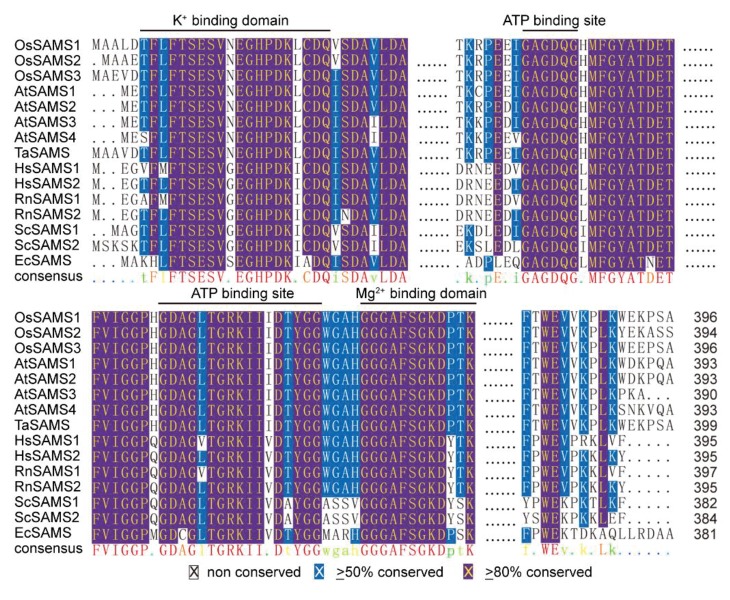
Multiple alignments of SAM synthetase proteins. The amino acid secquence of OsSASM1 synthetase protein (Q0DKY4.1) were aligned with Oryza sativa SAM synthetase 2 (OsSAMS2, P93438.1), O. sativa SAM synthetase 3 (OsSAMS3, Q9LGU6.1), Arabidopsis thaliana SAM synthetase 1 (AtSAMS1, P23686.2), A. thaliana SAM synthetase 2 (AtSAMS2, P17562.1), A. thaliana SAM synthetase 3 (AtSAMS3, Q9SJL8.1), A. thaliana SAM synthetase 4 (AtSAMS4, Q9LUT2.1), Triticum aestivum SAM synthetase (TaSAMS, B0LXM0.1), Homo sapiens SAM synthetase 1 (HsSAMS1, Q00266.2), H. sapiens SAM synthetase 2 (HsSAMS2, P31153.1), Rattus norvegicus SAM synthetase 1 (RnSAMS1, P13444.2), R. norvegicus SAM synthetase 2 (RnSAMS2, P18298.1), Saccharomyces cerevisiae SAM synthetase 1 (ScSAMS1, P10659.2), S. cerevisiae SAM synthetase 1 (ScSAMS1, P19358.3), and Escherichia coli SAM synthetase (EcSAMS, P0A817.2). ≥50% conserved and ≥80% conserved amino acids were in blue and purple, respectively. Four SAM synthetase signature motifs were indicated. SAM code numbers are from UniProt.